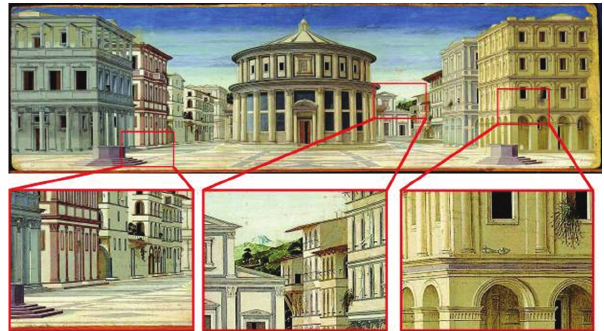
Figure 4: The marker less tracking creation.